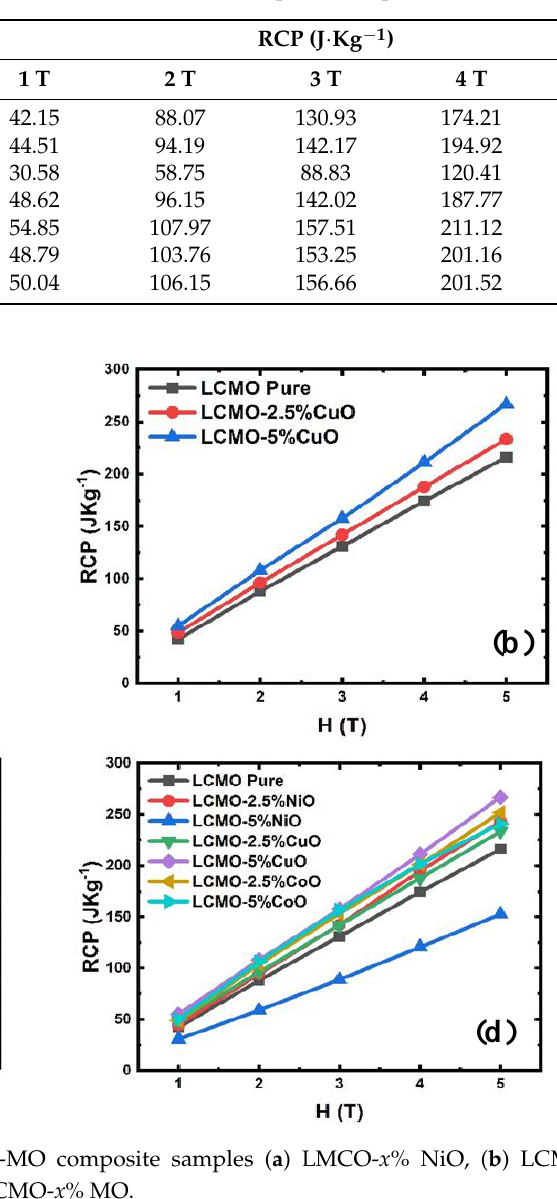
Table 7. Field dependent RCP values for LCMO-MO composite samples.